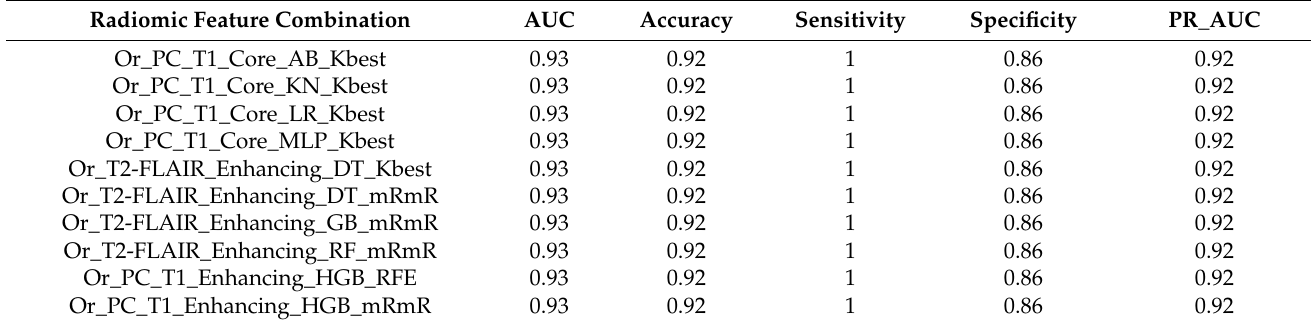
Table 1. Best 10 performances of multi-segmentation approaches, multi-machine learning classifiers, and multi-feature selection algorithms in discriminating IDH-mutant grade 4 astrocytomas from IDH-wild-type GBMs using original (Or) data